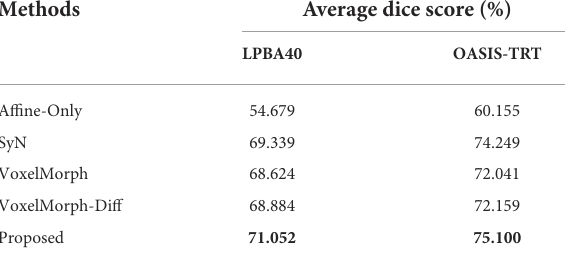
TABLE 2 The average dice scores (%) of all competing methods on the LPBA40 test set and OASIS-TRT test